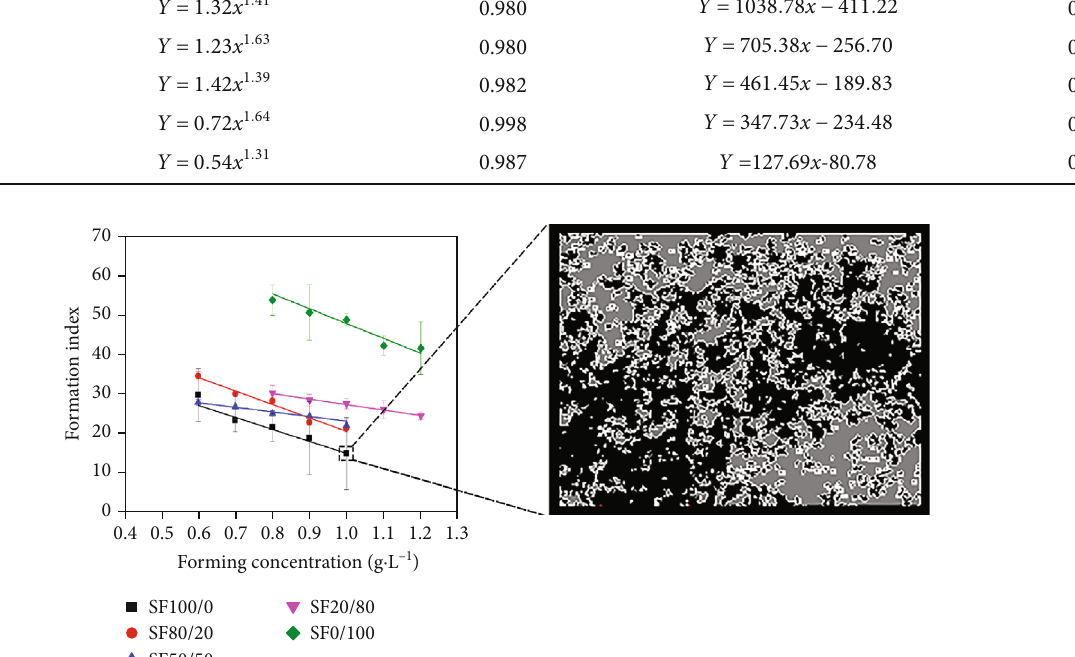
Figure 5: Formation index of meta-aramid papers with di ff erent fi ber/ fi brid ratios as a function of the formation concentration (the inset image shows a microscanned view of the aramid